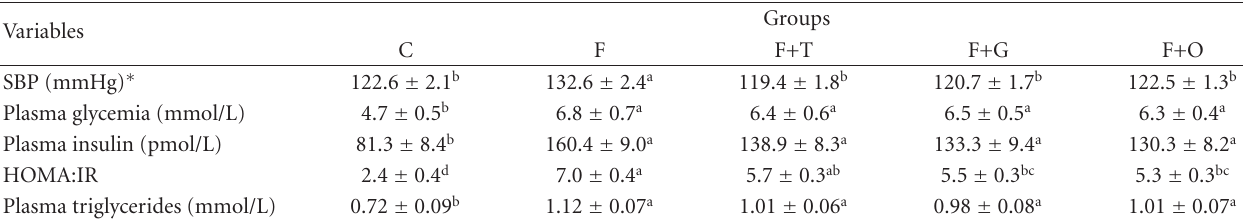
Table 2: Systolic blood pressure (SBP) and metabolic variables from C, F, F+T, F+G, and F+O groups. Variables